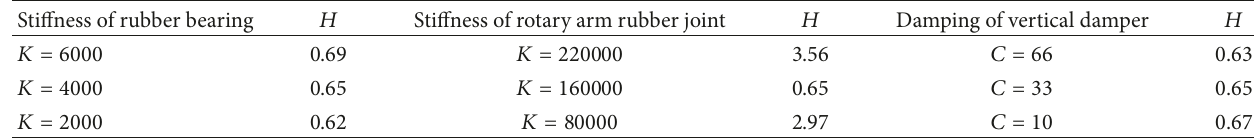
Table 2: The overall vibration isolation (changing parameters of the primary